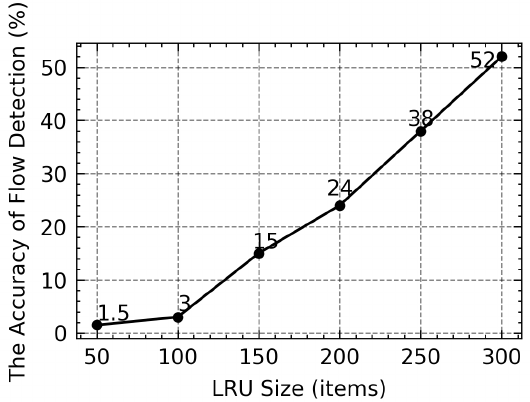
Figure 1. The influence of Least-Recently-Used (LRU) size on accuracy.